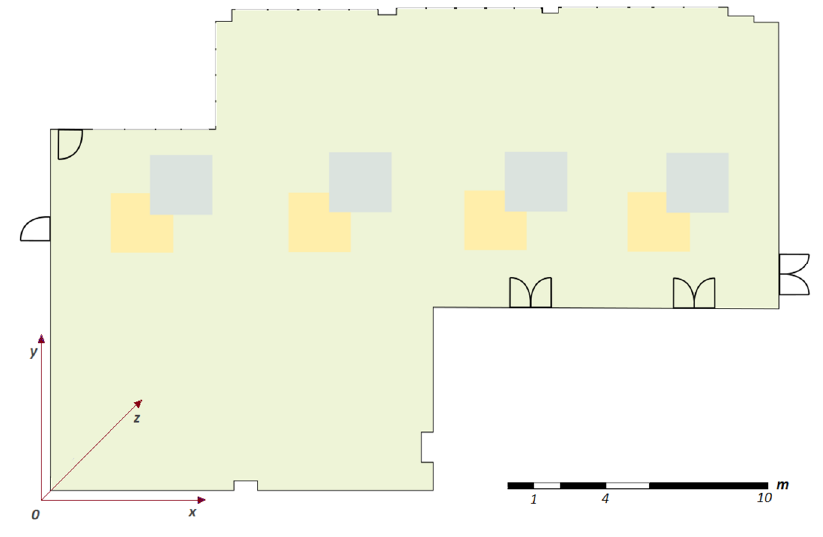
Figure 2. O ffi ce space [39]. Figure 2. Office space [39]. Figure 2. Office space [39].